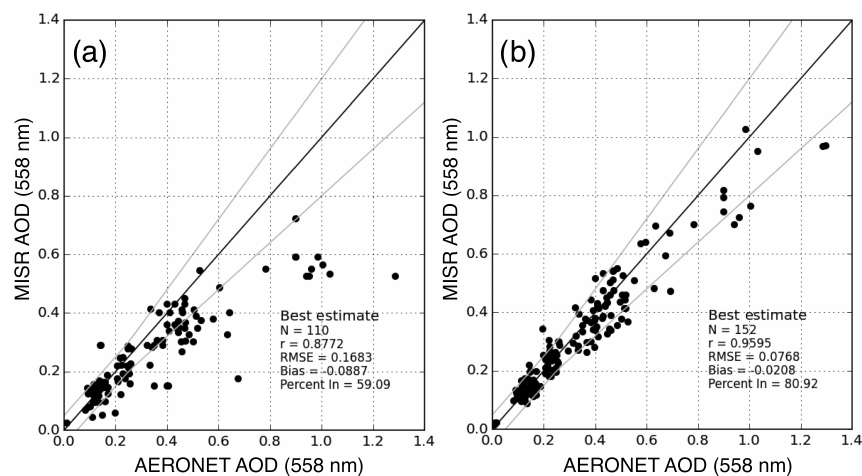
Figure 4. (a) Comparison of MISR V22 17.6km resolution AODs against AERONET-DRAGON interpolated to the MISR wavelength for all cases shown in Table 2. (b) Comparison of the 4.4km resolution AODs against AERONET-DRAGON.